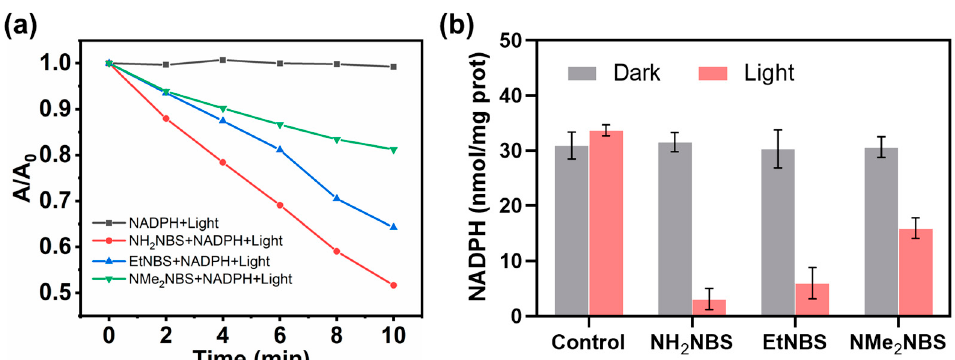
Figure 5. ( a ) The photocatalytic oxidation rate of NADPH (160 μ M) with three PSs (10 μ M) in the PBS solution ( A 0 and A represent the absorption intensities of NADPH at 330 nm before and after 635 nm laser irradiation at different times, respectively). ( b ) Total NADPH level in HepG2 cells incubated with three PSs (100 nM) in dark or light conditions. Light: 635 nm laser irradiation, 20 mW cm − 2 , 10 min.